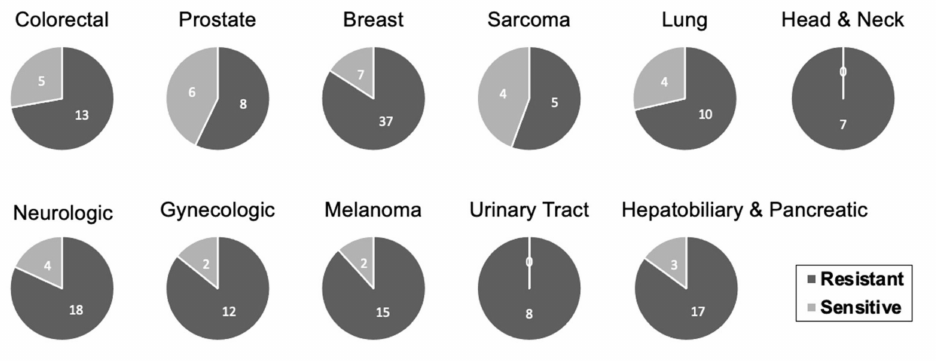
Figure 7. Cancer-specific response to chemotherapy. Each response represents a single experimental outcome. A larger fraction of all cell-lines showed resistance to chemotherapy. Cell-lines that were not frequently studied were categorized under an organ system. Sarcoma includes osteosarcoma, chondrosarcoma, and fibrosarcoma cell-lines. Head and neck cancers include head and neck squamous cell carcinoma, adenoid cystic carcinoma, and ameloblastoma cell-lines. Urinary tract cancers include renal cell carcinoma, renal cell carcinoma bone metastasis, and bladder cancer. Gynecologic malignan- cies include ovarian and cervical cancer cell-lines. Neurologic cancers include glioblastoma multiforme, neuroblastoma and astrocytoma cell-lines. Hepatobiliary and pancreatic cancers include hepatocellular, biliary tract, and pancreatic cancer